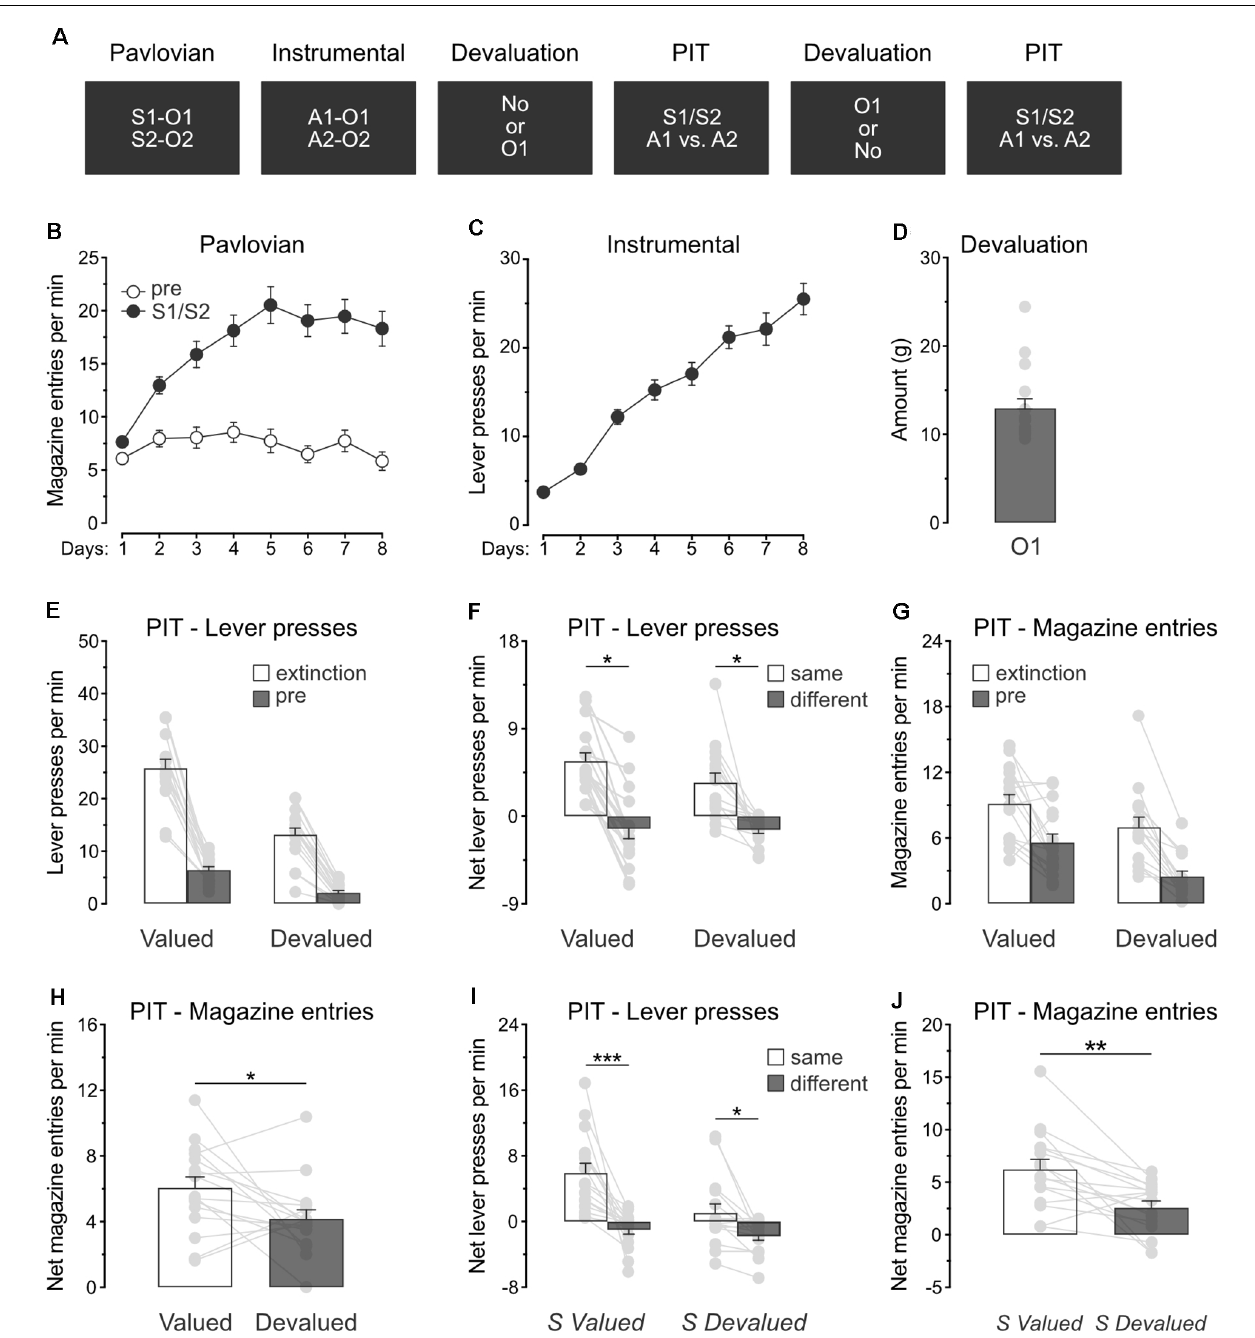
FIGURE 3 | Devaluation of a single predicted outcome spares specific PIT. (A) Design of the third experiment; S1/S2: clicker or noise stimuli (counterbalanced); O1/O2: grain pellet or sucrose solution outcomes (counterbalanced); A1/A2: left and right lever press actions. (B) All rats learned that the stimuli, S1 and S2, predicted food outcomes O1 and O2. (C) All rats learn to perform the left and right lever press actions, A1 and A2, to earn food outcomes O1 and O2. (D) During outcome devaluation via sensory-specific satiety, rats consumed a substantial amount of O1. (E) Outcome devaluation reduced lever press responding during the extinction and baseline (pre) period of the specific PIT test. (F) Outcome devaluation spared specific PIT. (G) Outcome devaluation reduced magazine entries during the extinction and baseline (pre) period of the specific PIT test. (H) Although magazine entries were reduced after outcome devaluation, rats showed substantial levels of magazine entries in the presence of the stimuli. (I) The stimuli promoted specific PIT whether they predicted a valued (S valued) or devalued (S devalued) outcome. (J) Although magazine entries were reduced after outcome devaluation, the stimuli elicited substantial levels of magazine entries whether they predicted a valued (S valued) or devalued (S devalued) outcome. Data are shown as mean ± SEM. Asterisks denote significant effect (* p < 0.05; ** p < 0.01; *** p < 0.001).